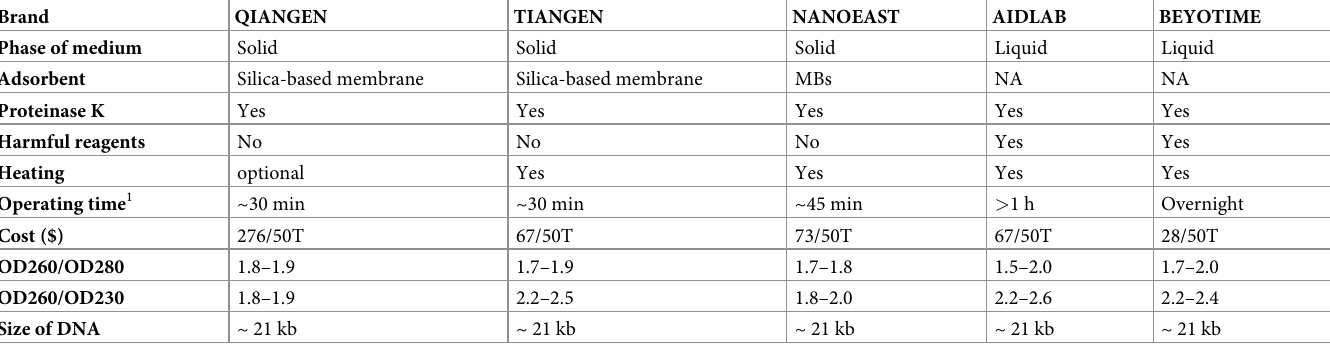
Table 4. Summary of the current